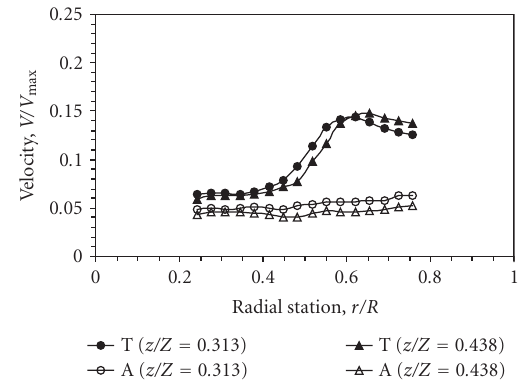
Figure 13: Comparison of di ff erent section heights for section 1 ( H 2 /H 1 = 0 .